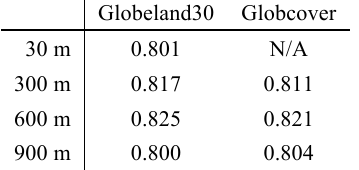
Table 1. AUC scores for all of the models